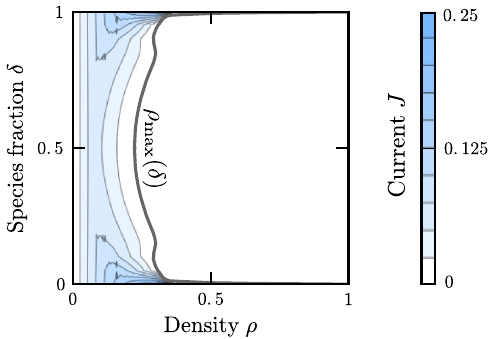
FIG. 19. Current-density relation obtained from stochastic simulations with W ¼ 13 lanes and L ¼ 16 384 sites. The emerging current of an arbitrary lane (blue) shows a dependence not only on the average system density but also on the fraction of lane-switching particles, δ . The system jams at a maximal density ρ δ Þ (bold gray line); densities between ρ max ð occupation are not realized in the stationary state.